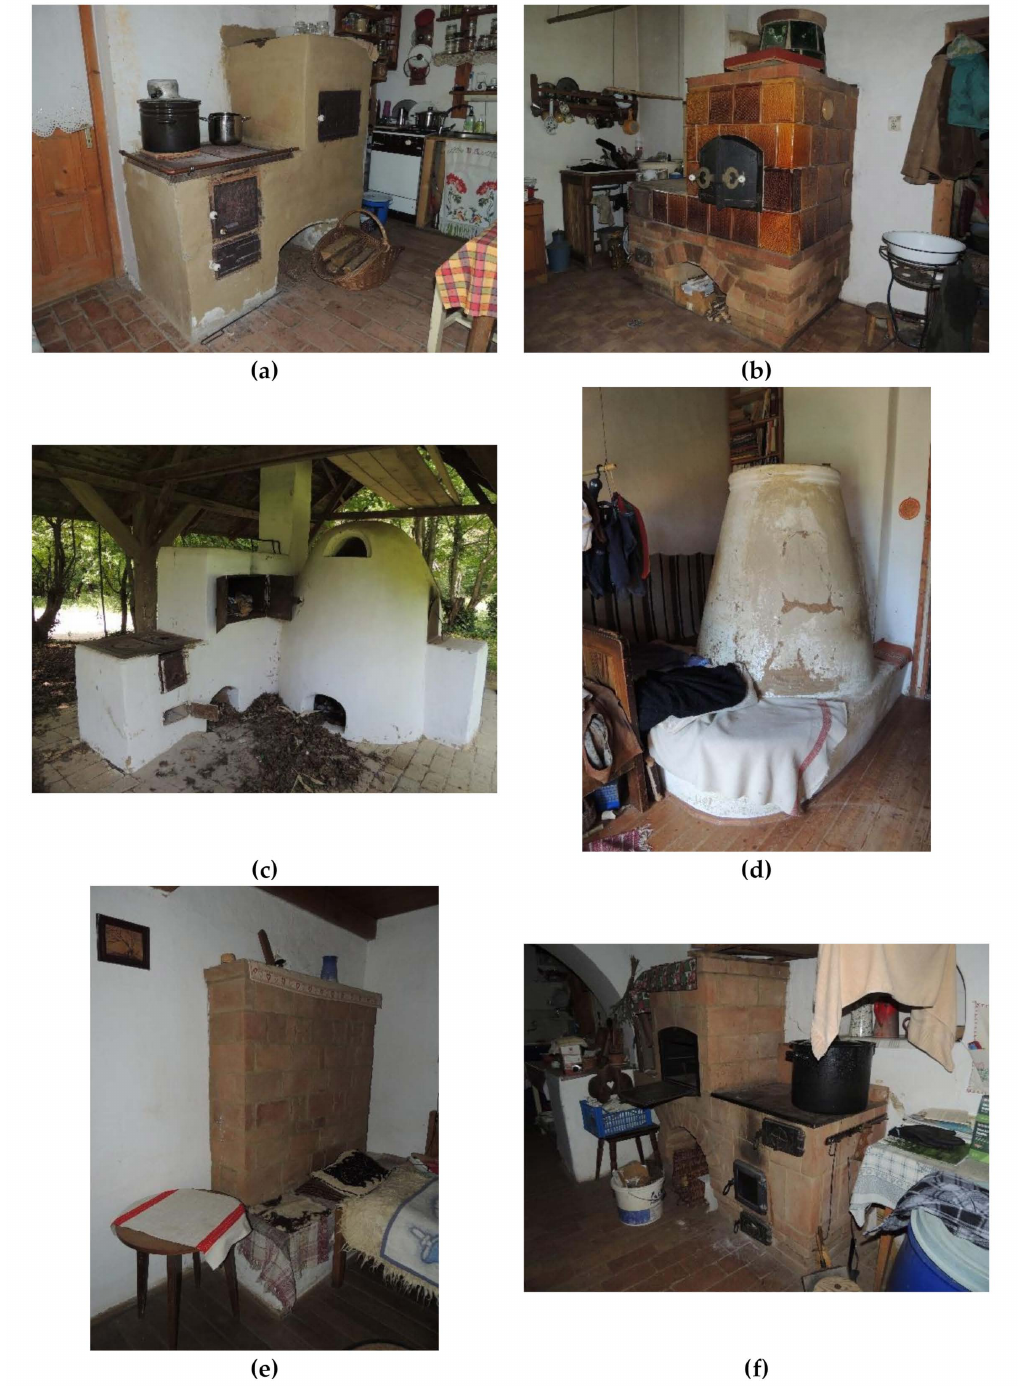
Figure 9. Example of biomass use. ( a , b ) Cooking stove, ( c ) furnace of the community, ( d ) beehive oven, ( e ) mass stove and its other side, and ( f ) cooking stove (photographs by the